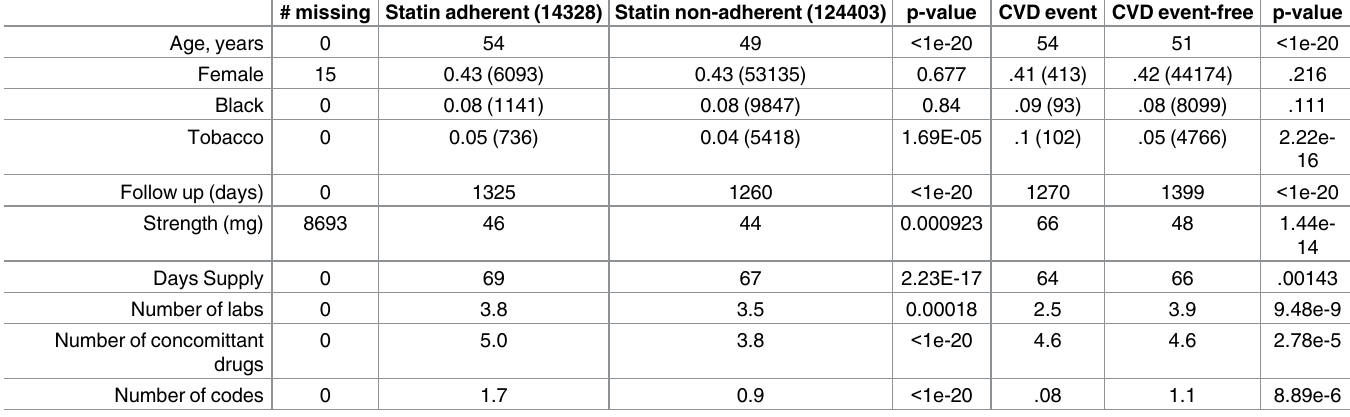
Table 2. Baseline patient and statin characteristics of cohort (N =